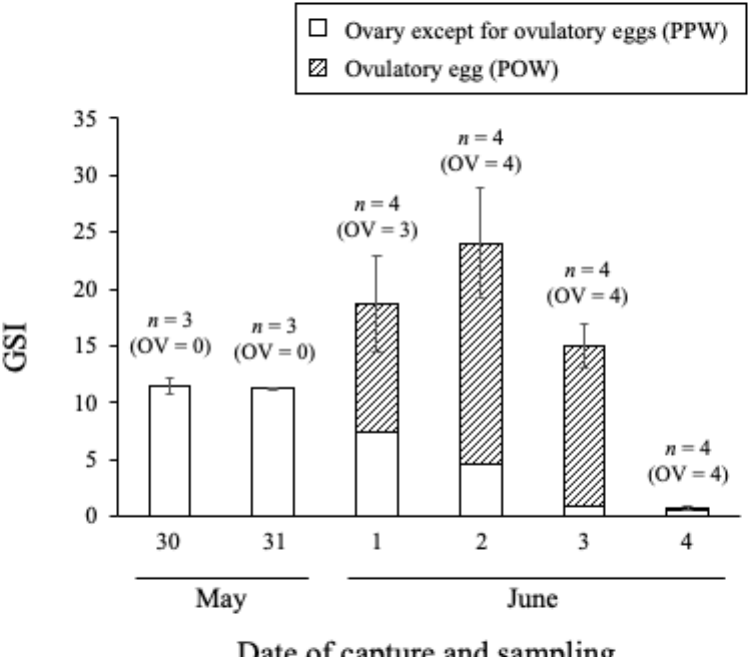
Figure 5. Gonadosomatic index of aggregating Epinephelus merra females in the observation area after the full moon. Open columns show the proportion of pre-ovulatory oocytes (PPW), and hatched columns show the proportion of ovulatory eggs (POW). Error bars indicate standard deviation, and the number of samples is shown as “ n ”. OV, number of ovulated individuals.